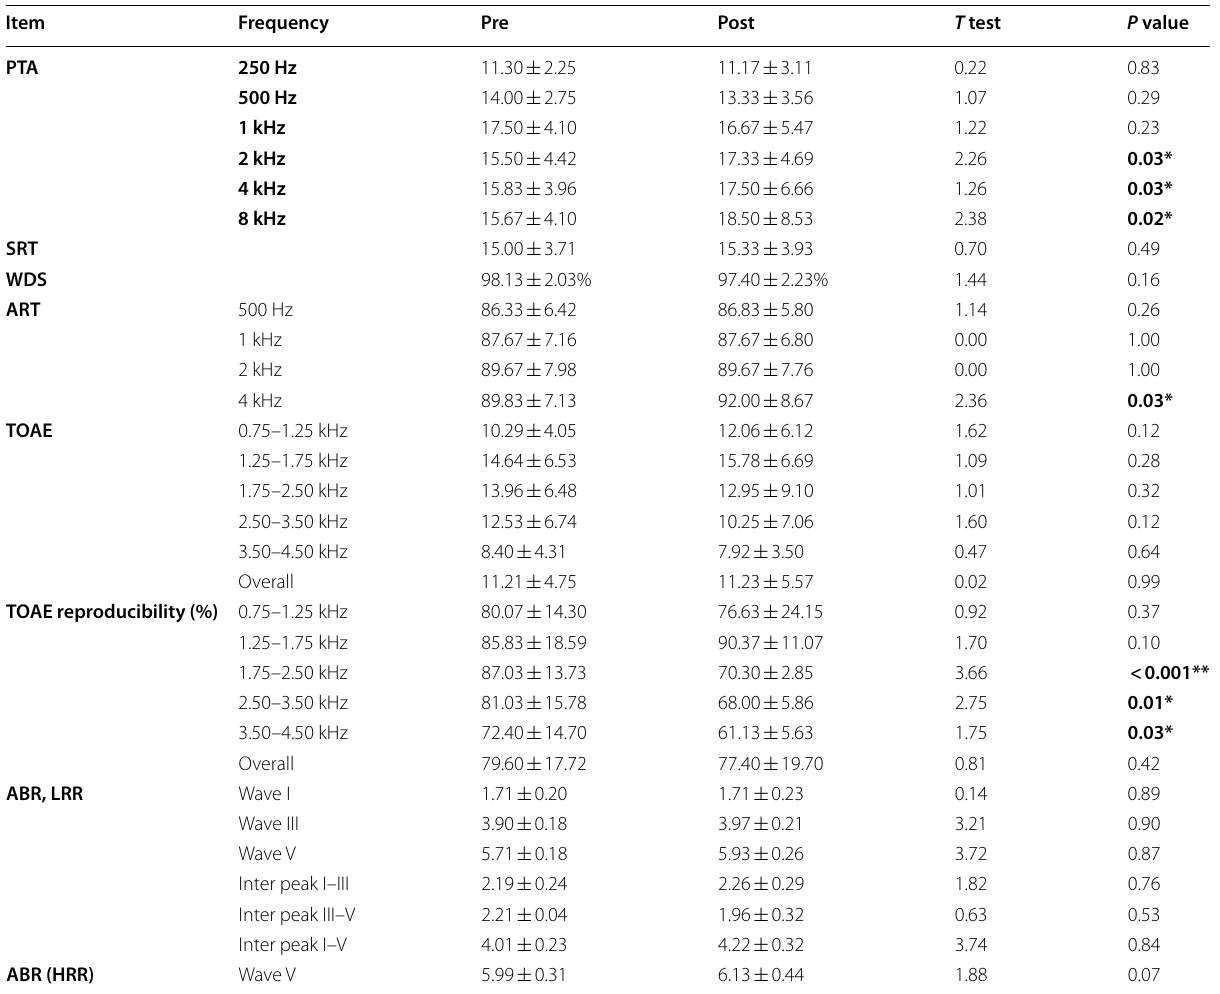
Table 2 PTA, SRT, WDS, ART, TOAE, and ABR of the right ear before and after treatment